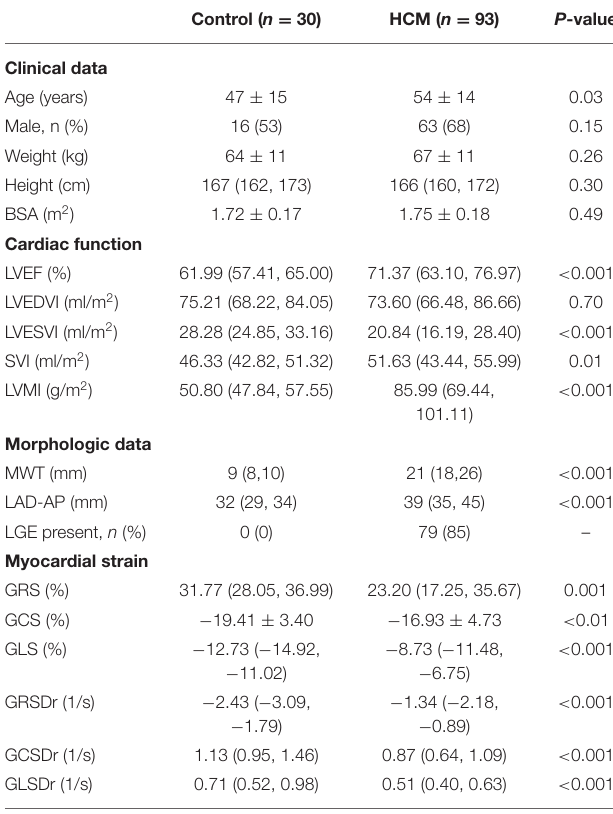
TABLE 1 | The baseline characteristics of all